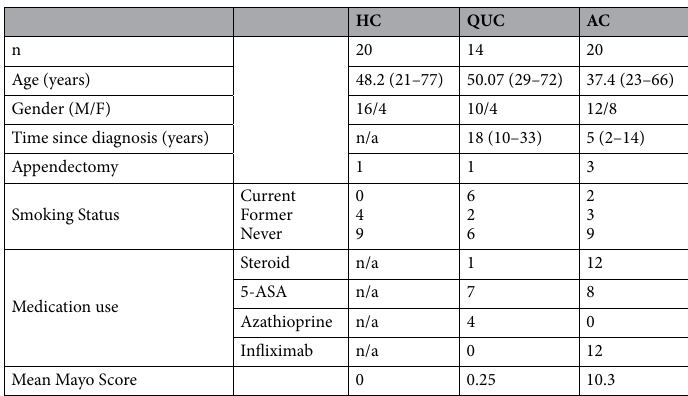
Table 2. Summary of characteristics of individuals in each cohort.